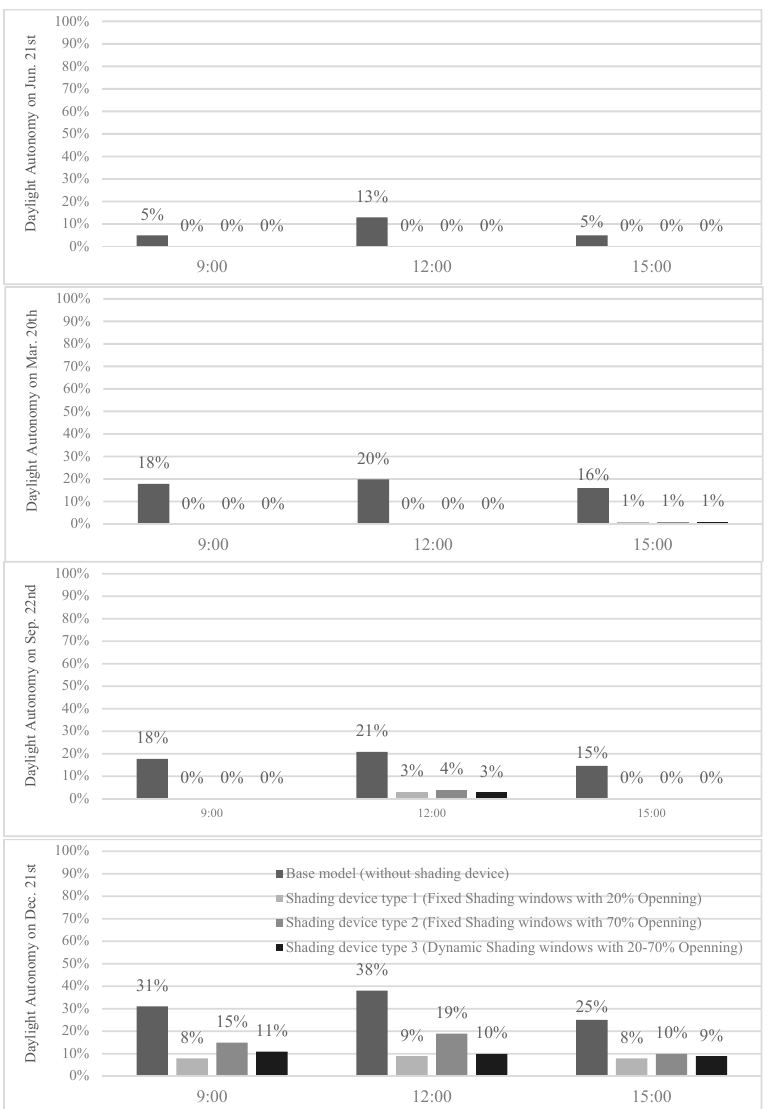
Figure 14. Useful Daytime Illumination above 1800 lux.